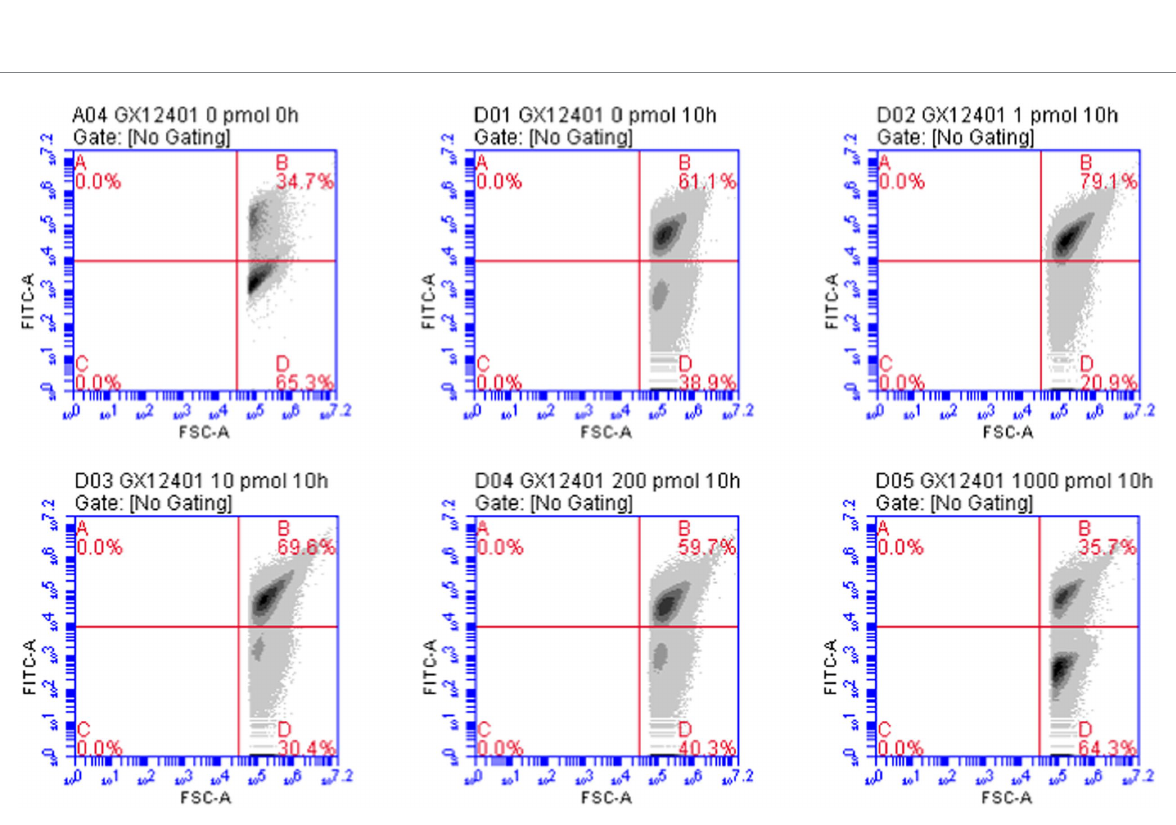
FIGURE 9 Flow cytometry results map. GX12401: Rhodococcus sp. (GX12401) normal cells and VBNC cells, A04: VBNC cells before resuscitation flow analysis map, D01 ~ D05: adding 0 picomolar concentrations, 1 pM concentrations, 10 picomolar concentrations, 200 picomolar